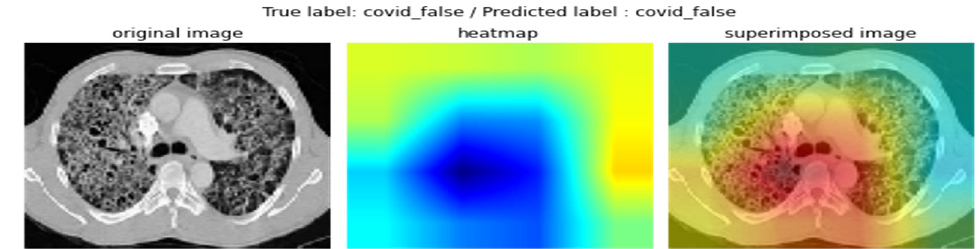
Figure 10. Heap map and super imposed image for the study of pulmonary amalgamation.